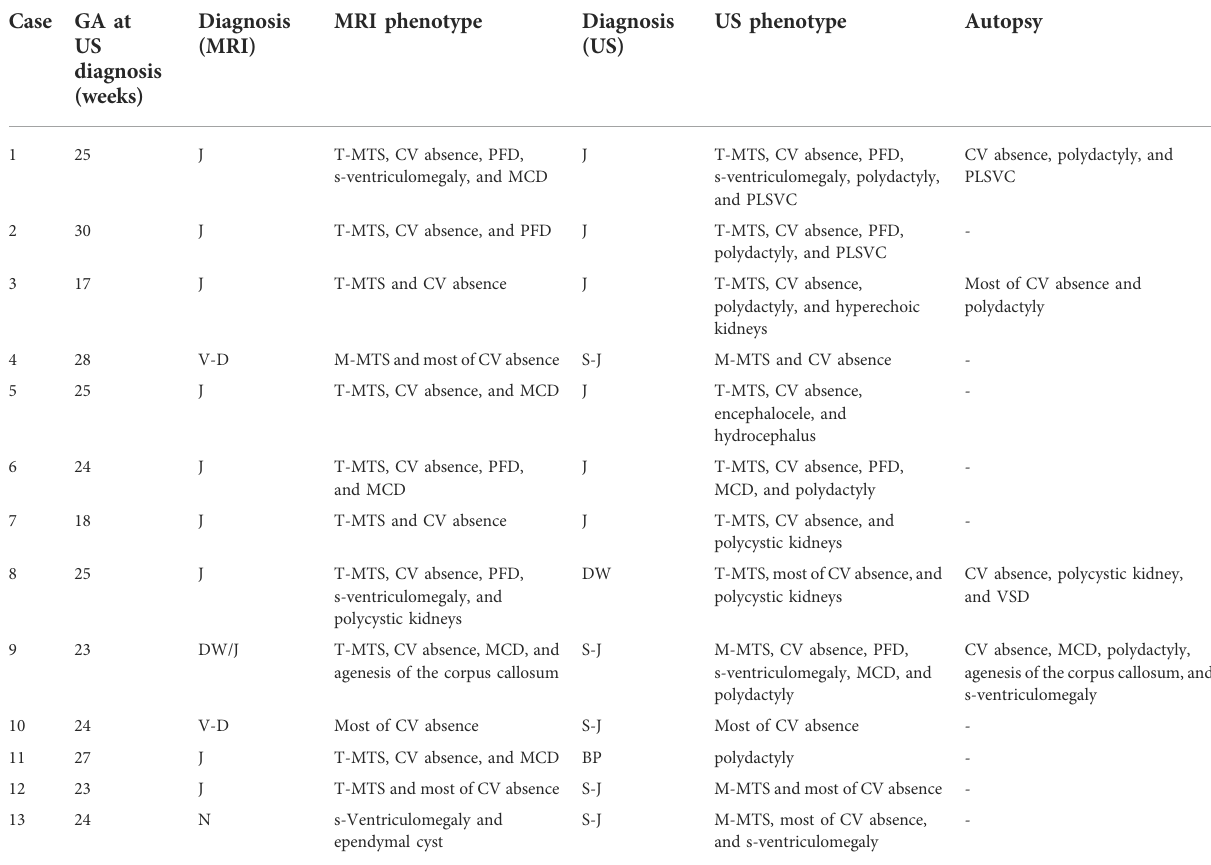
TABLE 1 Prenatal imaging phenotypes and diagnosis of 13 cases ’ fetuses. Case GA at